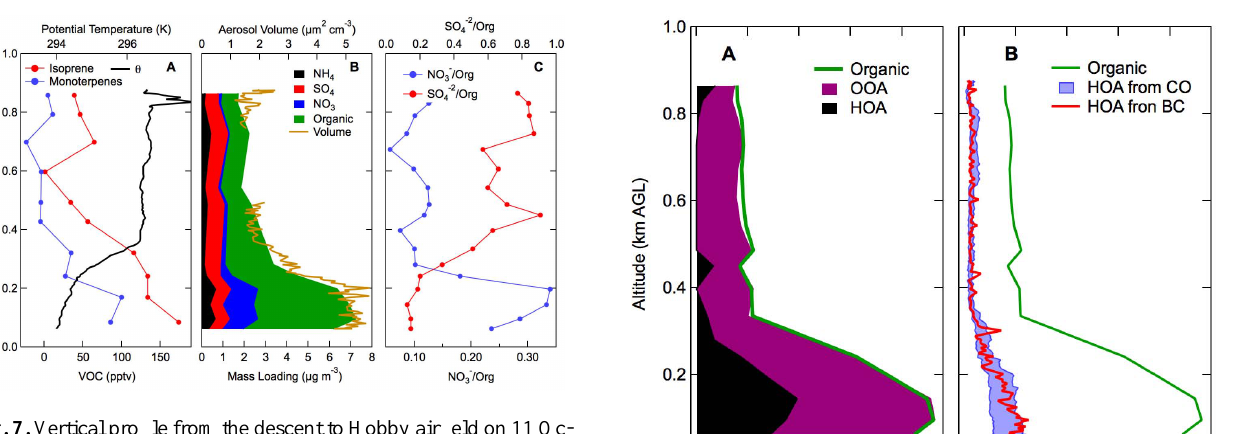
Fig. 7. Vertical profile from the descent to Hobby airfield on 11 Oc- tober, just after midnight. (A) Mixing ratio of isoprene and monoter- penes (bottom axis) and potential temperature profile (top axis). (B) Mass loading of ammonium, sulfate, nitrate and organic from the AMS (bottom axis) and total aerosol volume (top axis). (C) Ratio of nitrate and sulfate to organic mass (bottom and top axes, respec- tively).